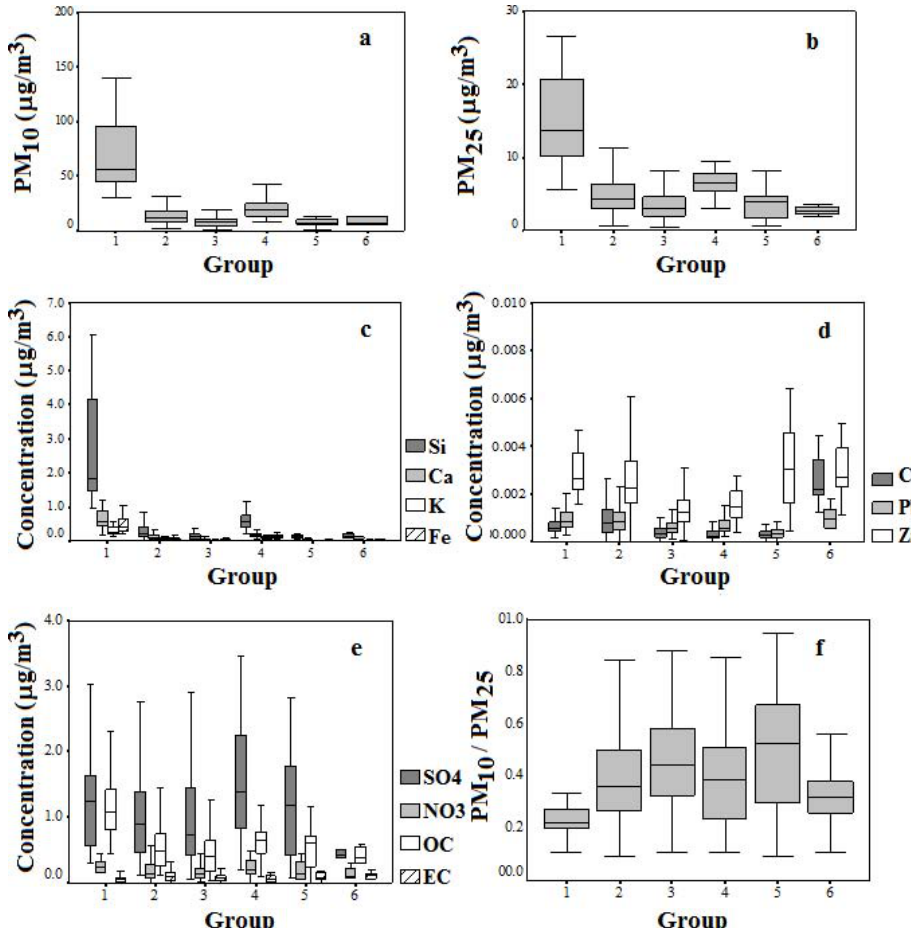
Fig. 3. Physical and chemical characteristics of aerosol samples in different clusters as generated by the hierarchical cluster analysis of all IMPROVE observation data from 2000 to 2007 at the GUMO1 site: (a) PM 10 mass; (b) PM 2 . 5 mass; (c) crustal elements, Si, Ca, K, Fe; (d) anthropogenic trace elements, Cu, Zn, Pb; (e) Sulfate, Nitrate, OC and EC; and (f) PM 2 . 5 /PM 10 ratio. The bottom and top edges of the box indicates the 25th and 75th percentile and the line in the box indicates the 50%. Group 1 was identified as the local dust group.